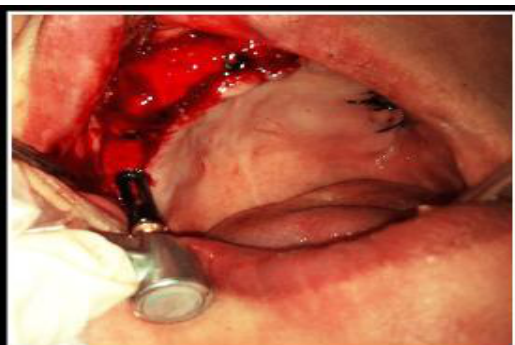
Figure 2: Preparing Implant Bed by Drilling with Sequential Larger Drills. Anosteotome tip No D2.0 mm, No D3.0 mm and/or No D3.8 mm from osteotome kit (Friadent, company) was inserted and gentle tapping applied by surgical mallet to allow for controlled green- stick fracture of the sinus floor, as in figure (3). Entrance into the sinus membrane space (SMS)was manifested by changing in the voice resonance and tactile sense of the surgeon.